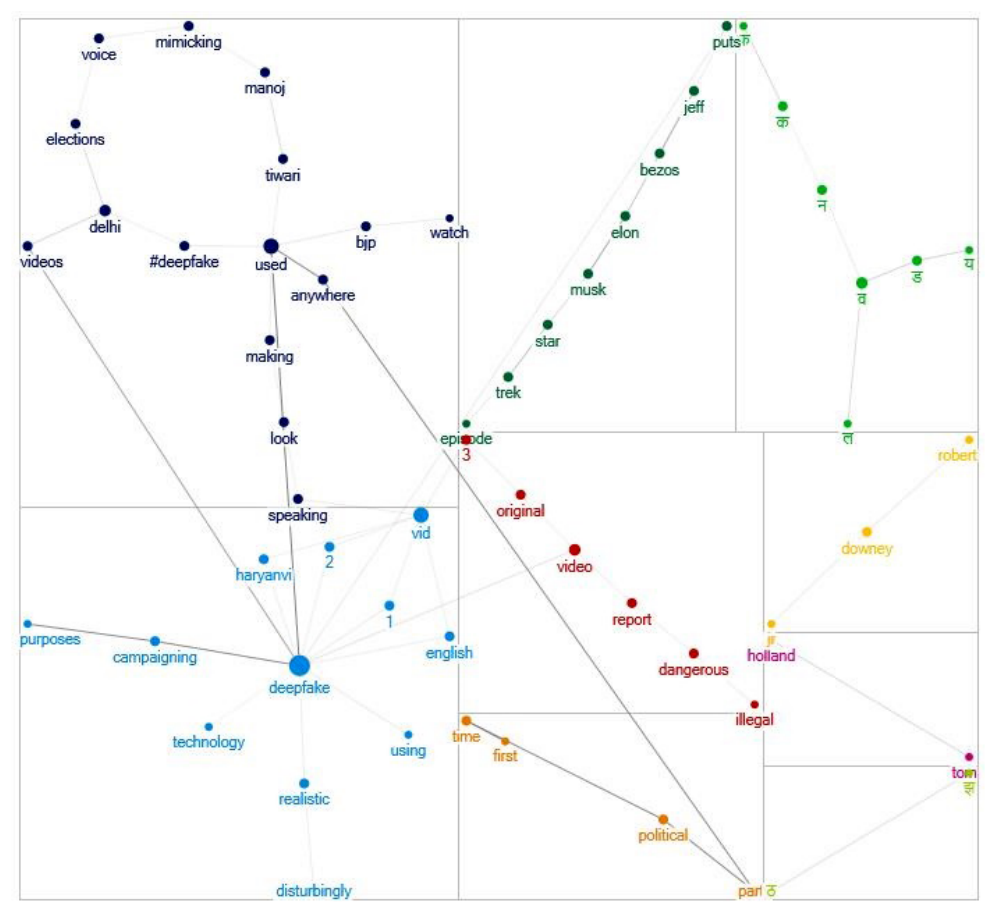
Figure 6. Illustration of the most relevant conversation topics regarding